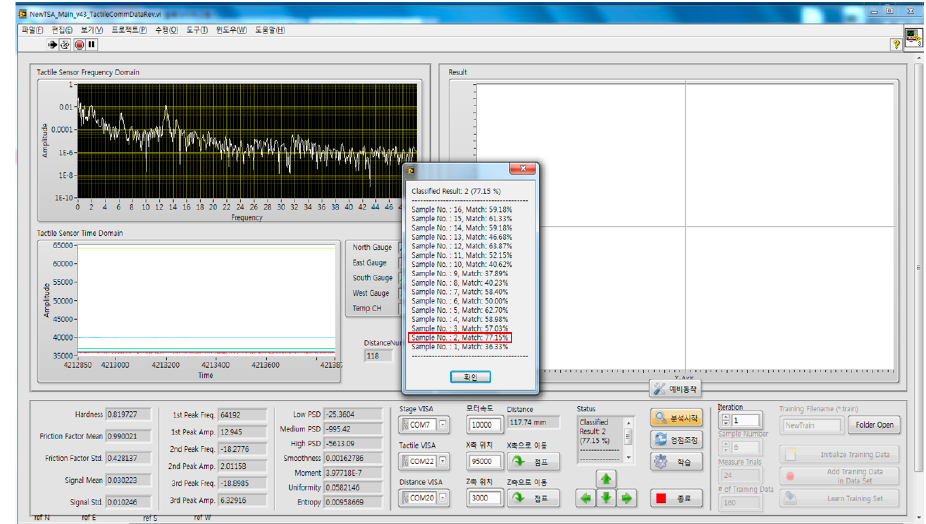
Figure 8. An image showing the result of a tactile identification experiment with a fine fabric (# 2) sample based on the database built in the training mode.